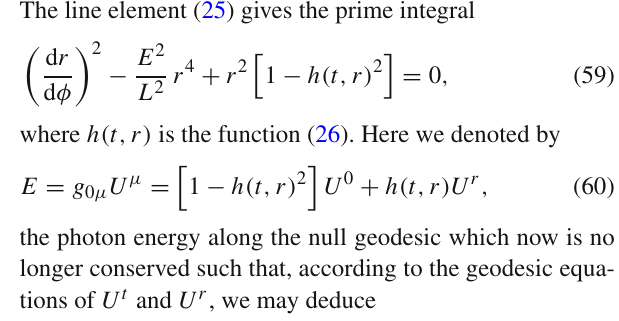
Fig. 2 The radii of the photon spheres (dashed lines) of the dynamical particles in the matter-dominated universe (left panel) and de Sitter expanding universe (right panel). The photon spheres are formed before theeventhorizonswhichappearatthetime t cr